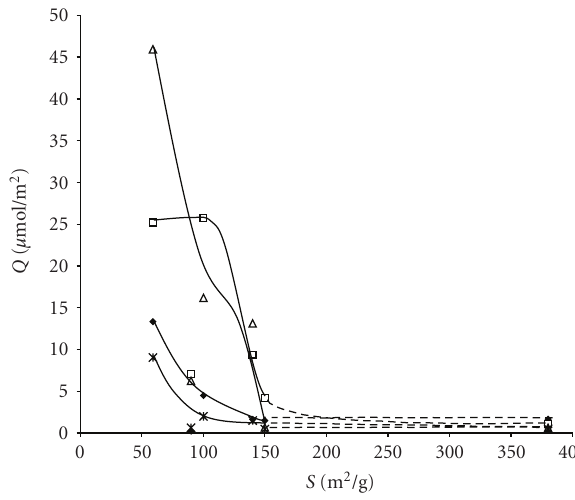
Figure 6: Distribution of adsorption centers as a function of their p K a values on the surface of electron beam evaporated silica with the specific surface area S = 100m 2 /g ( ) in comparison with aerosil A-90 produced by Degussa Co. ( ) Note: the content of adsorption centers with p K a 14.2 is reduced 10-fold for the presentation